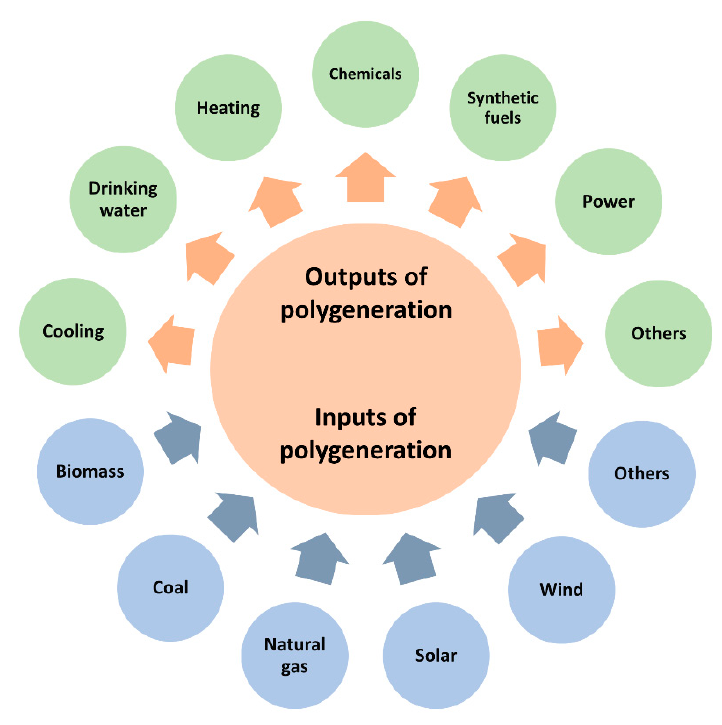
Figure 1. Schematic of inputs and outputs of typical polygeneration systems.